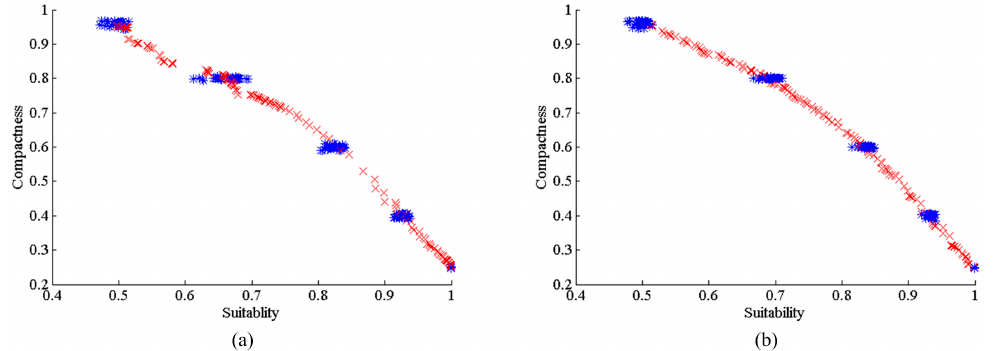
Figure 19. Pareto solutions’ distribution of ABC and AIS. Two randomly-selected Pareto fronts obtained by AIS ( a ) and ABC ( b ) are represented by red crosses. Five solutions in each Pareto front (forty Pareto fronts in total) with the minimum or maximum compactness values—compactness values nearest to 0.4, 0.6 and 0.8—are represented by the blue stars.